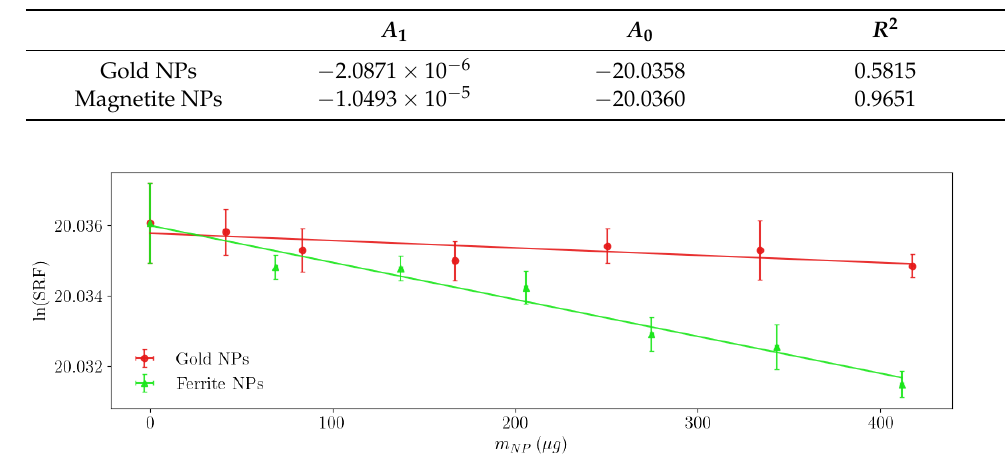
Table 2. Fitting results of the experimental data.